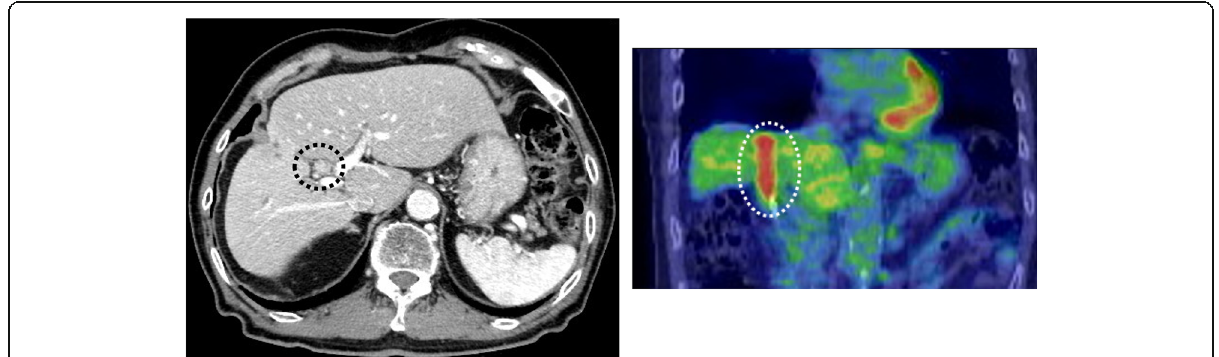
Fig. 2 Computed tomography (axial image, black-dotted line circle) and PET – CT (coronal image, white-dotted line circle) revealed an intrahepatic bile duct tumor with the accumulation of